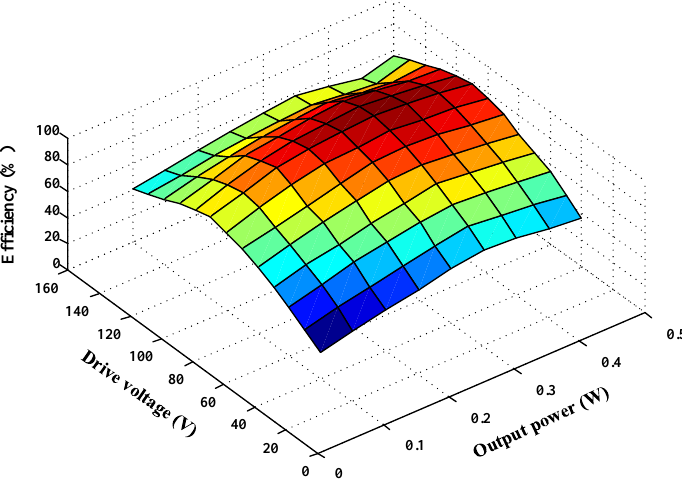
Figure 17. Conversion efficiency of the flyback stage vs. drive voltage and output power.